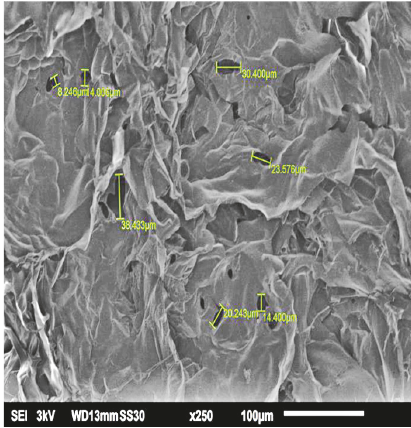
Figure 5: SEM images chitosan/TiO 2